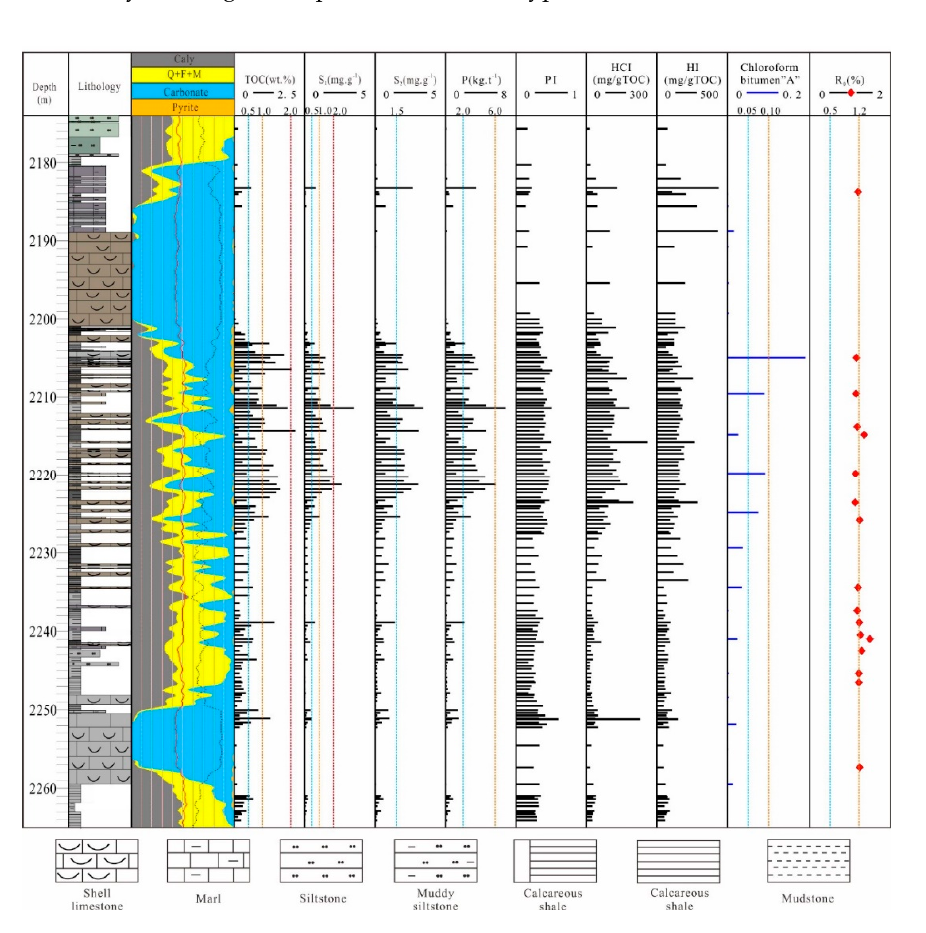
Figure 3. The geochemical and mineralogy characteristics for well FY3-2 in the Jurassic Da’anzhai member. Q: quartz; F: feldspar; M: mica. P = S 1 +S 2 ; PI = S 1 /(S 1 +S 2 ); HCl = S 1 /TOC × 100; HI = S 2 /TOC × 100. The blue, orange, and red dash lines show the classification borders of general, good, and excellent qualities of source rock.